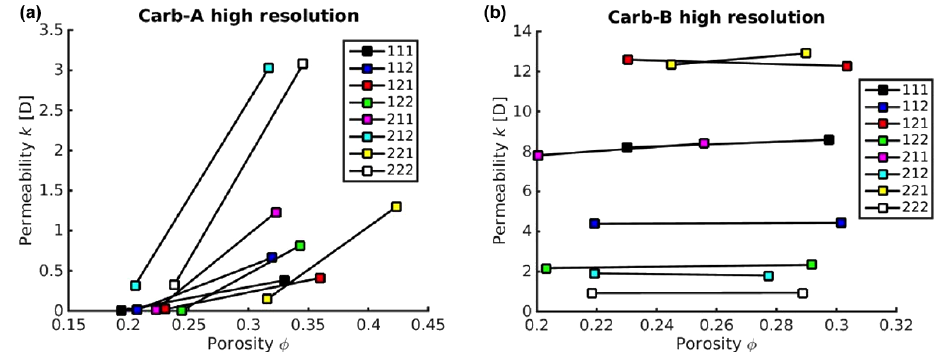
Figure 7. Intrinsic permeability simulated for the eight subvolumes. Results are given for the extreme porosities configuration of Carb-A (left-hand side) and Carb-B (right-hand side) high-resolution samples.